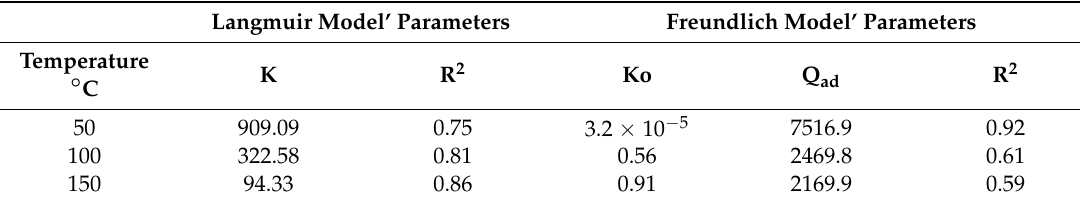
Figure 10. Coverage of ammonia over CAG 90 and model representation. Freundlich model presented by dashed lines and Langmuir model by solid lines. Table 9. Langmuir and Freundlich models’ parameters and statistical adjustment.